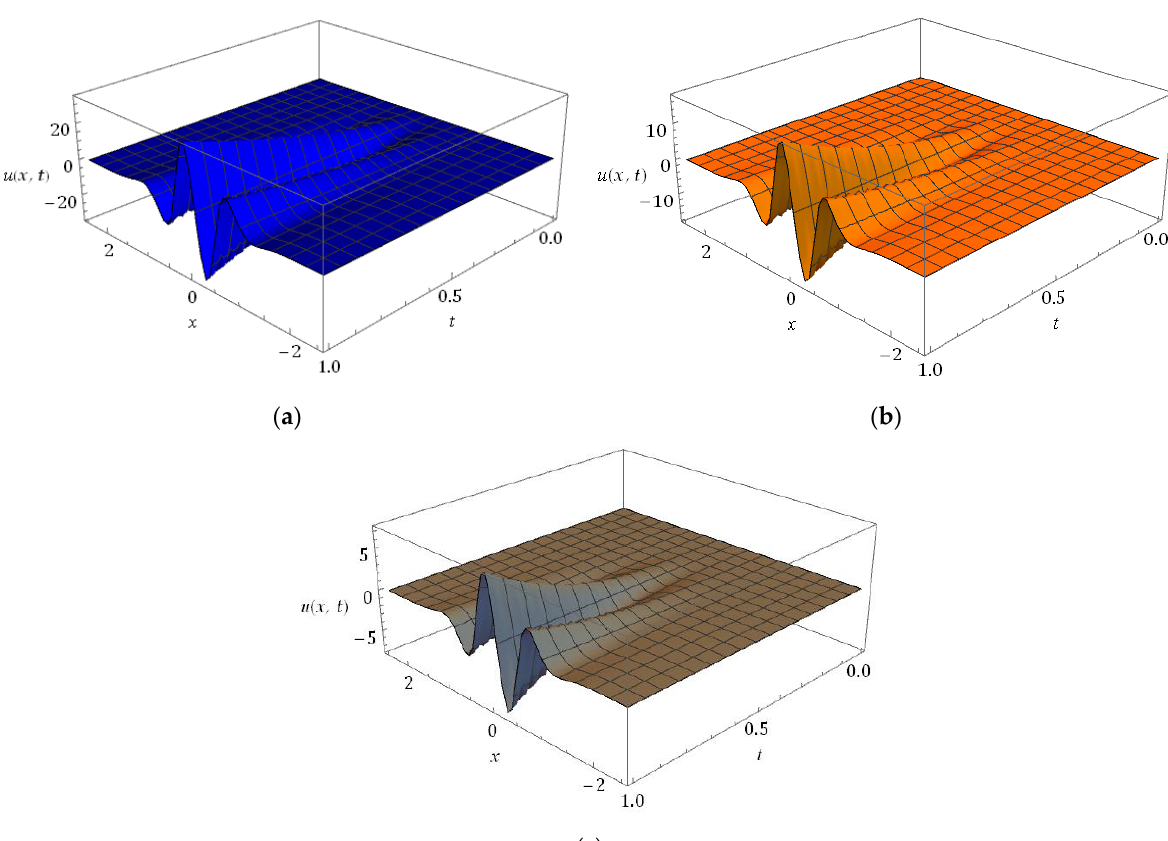
Figure 1. Surfaces of 𝑞 -HATT solution for (𝒂) 𝛼 = 0.50 , (𝒃) 𝛼 = 0.75 and (𝒄) 𝛼 = 1 at 𝑛 = 1, ℏ = −1, 𝛽 = 1, 𝑐 = −1, 𝜅 1 = 1 and 𝜌 = 0.001 for Case I.